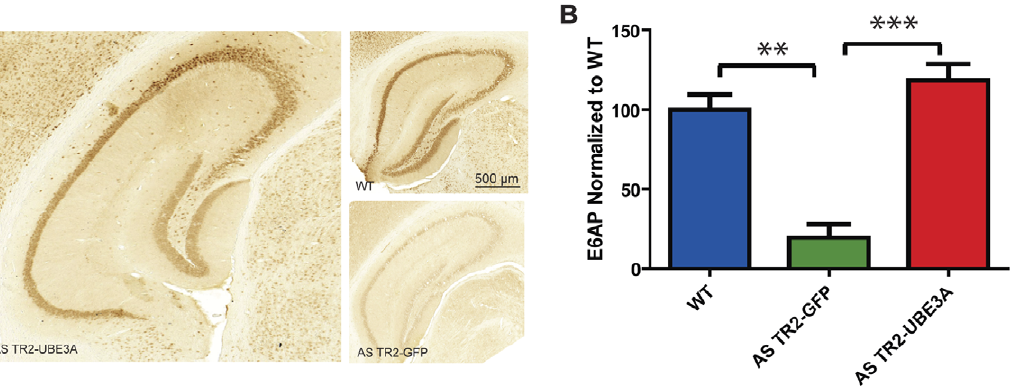
Figure 1. E6-AP protein levels were restored to wildtype levels in the TR2-UBE3A treated AS mice. (A) Representative coronal slices through the hippocampus from each group stained for E6-AP. (B) Quantitative analysis of the IHC revealed a significant increase in E6-AP expression in the WT and AS-TR2-UBE3A mice compared to the AS TR2-GFP group, while there was no significant change between the WT and AS TR2-UBE3A mice. Results shown represent the mean with standard